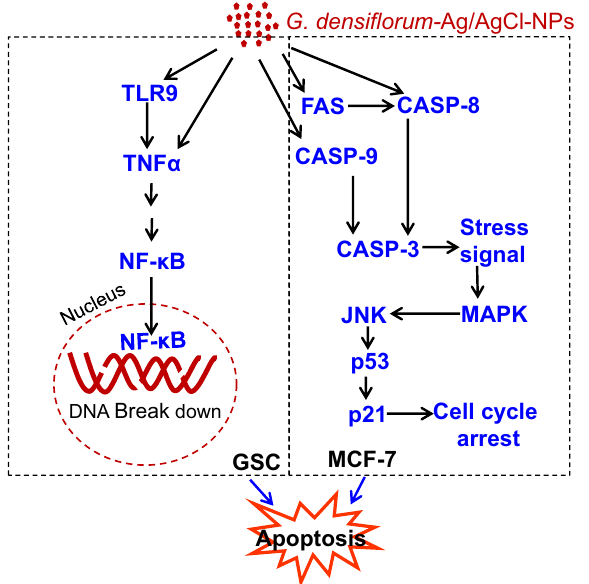
Figure 8. Schematic representation of the effects of G. densiflorum -Ag/AgCl-NPs on the induction of apoptosis in GSCs and MCF-7